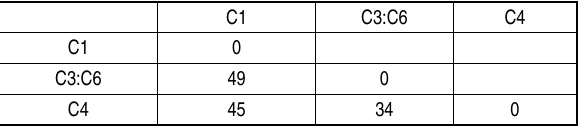
Table 23. Single linkage cluster matrix